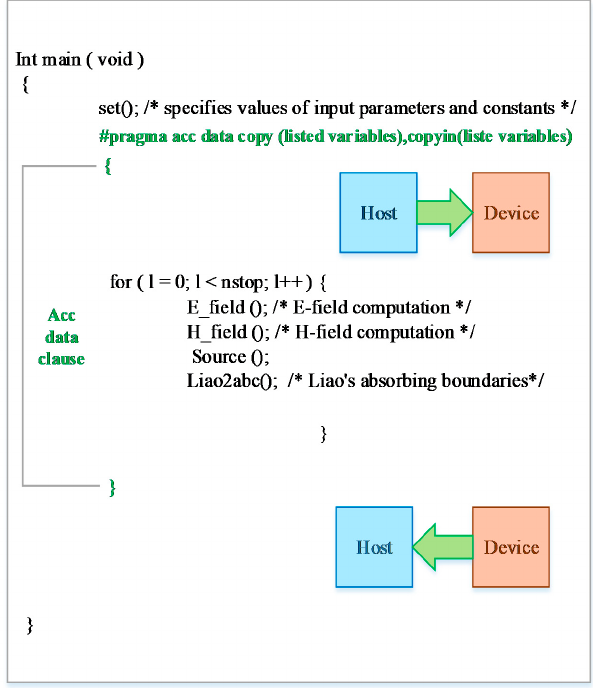
Figure 4. Optimized data locality.